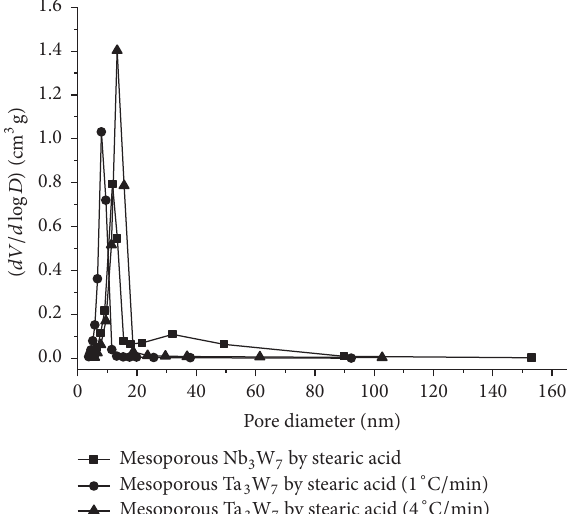
Figure 7: BJH pore size distributions of mesoporous Nb 3 W 7 oxide (stearic acid), mesoporous Ta 3 W 7 oxide (stearic acid, 1 ∘ C/min), and mesoporous Ta 3 W 7 oxide (stearic acid, 4 ∘